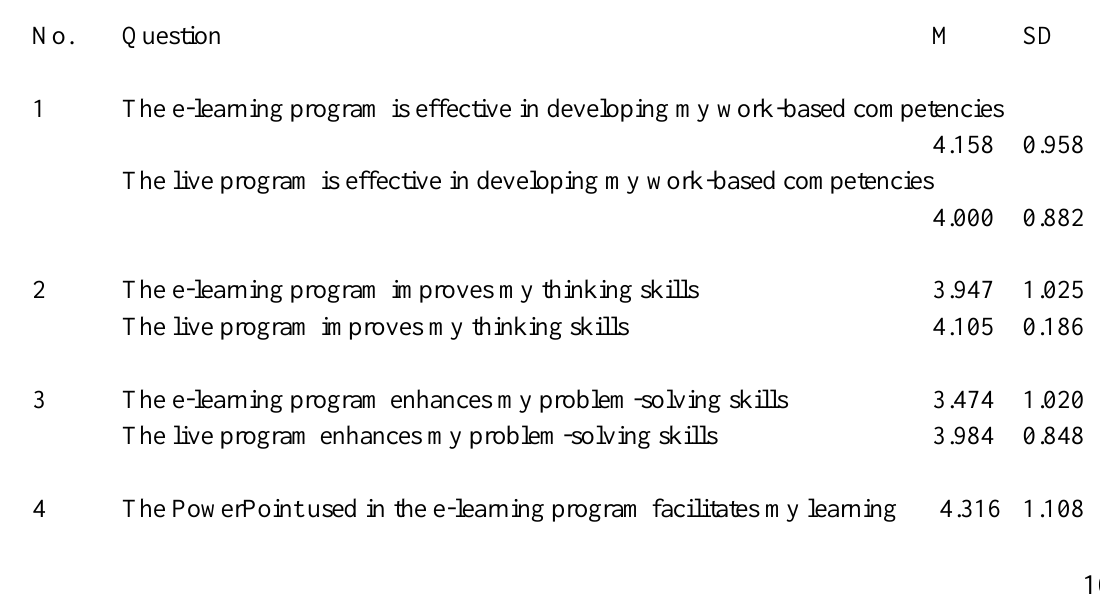
E-Learning and Live Program Post-Test